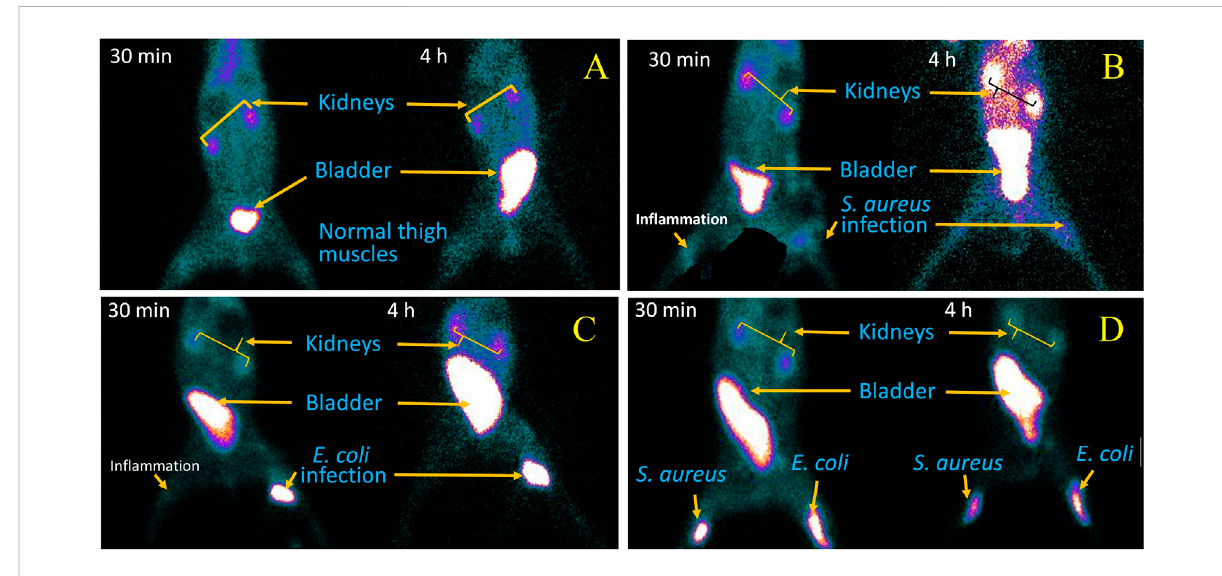
FIGURE 6 SPECTgammacamerascintigraphyimages,at30 minand4 hpostinjectionof 99m Tc-ertapenemradiopharmaceutical,of: (A) healthyrabits, (B) S. aureus infection and in fl ammation induced rabits, (C) E. coli infection and in fl ammation induced rabits and, (D) S. aureus and E.coli infection induced